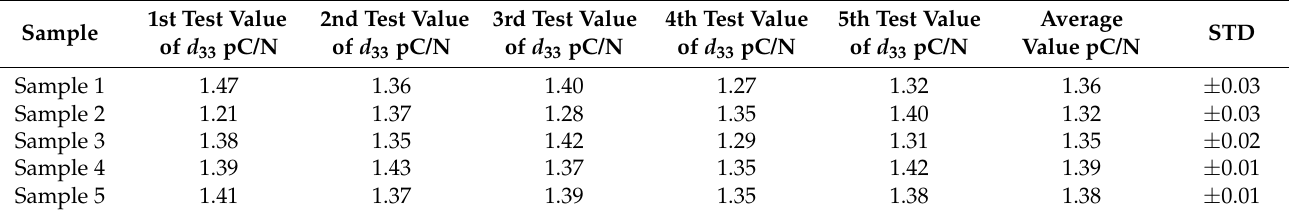
Table 3. Five piezoelectric film sensor samples were tested five times.